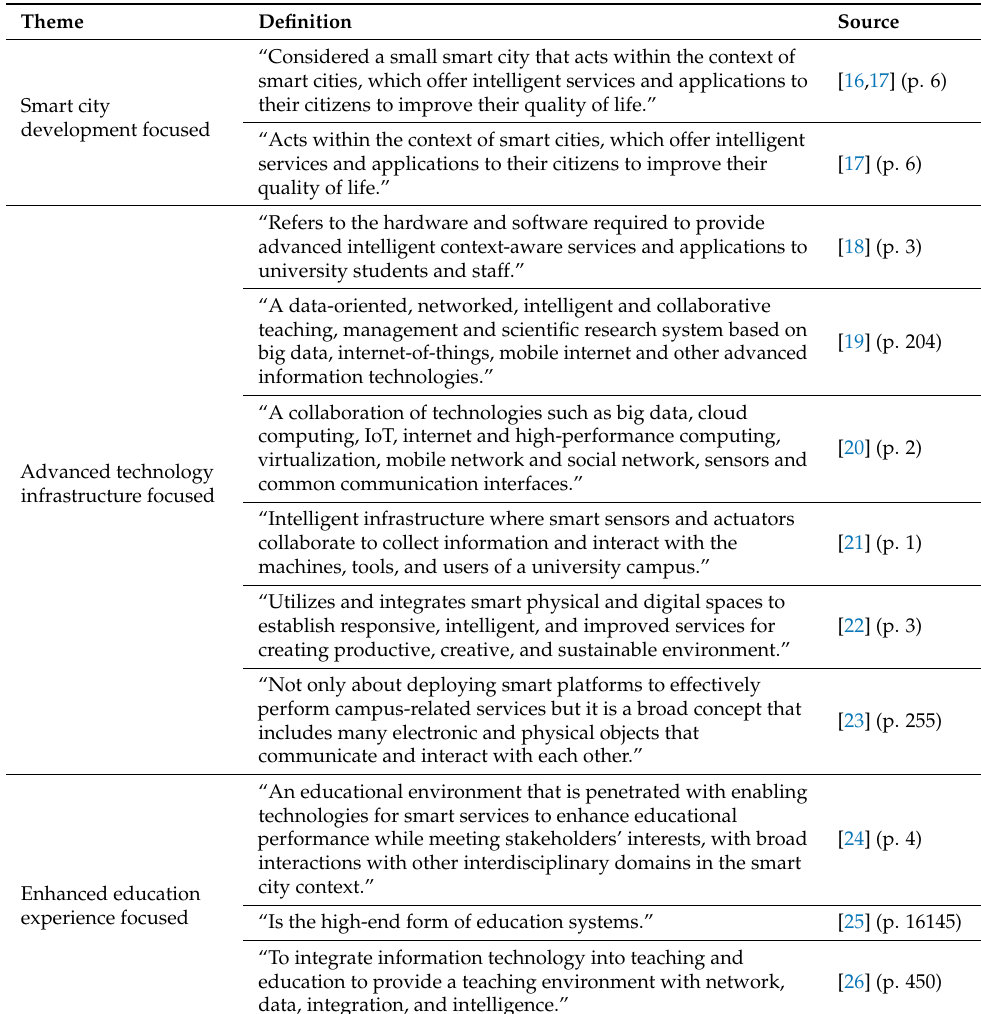
Table 1. Definitions of a smart